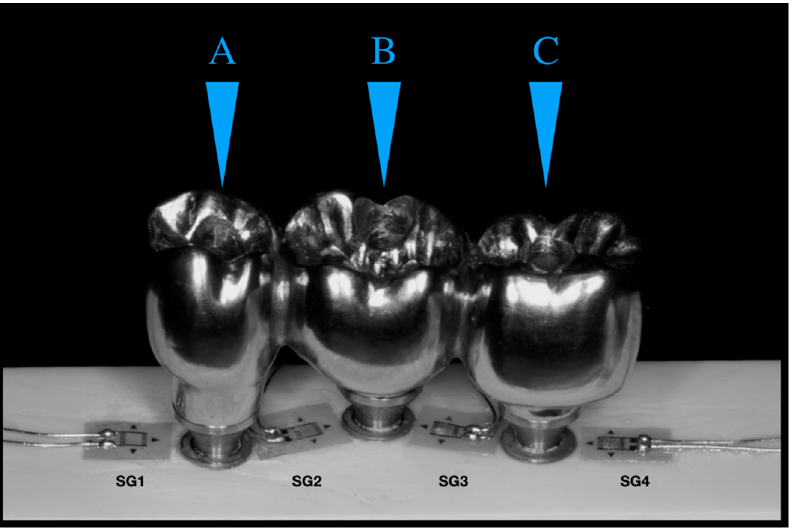
Figure 5. Strain gauges are arranged between the implants and the application load points. Letters showing the different loading points.